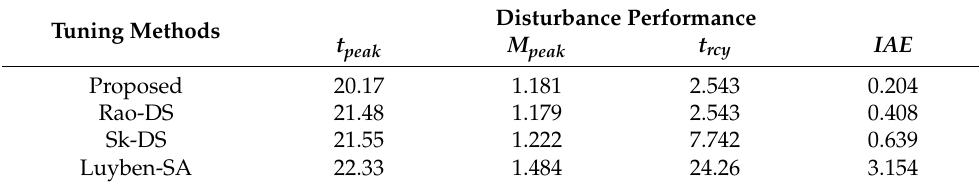
Figure 10. Regulatory responses to disturbance in perfect model of IFOPTD. Table 7. Quantitative comparison of responses to disturbance in perfect model of IFOPTD.